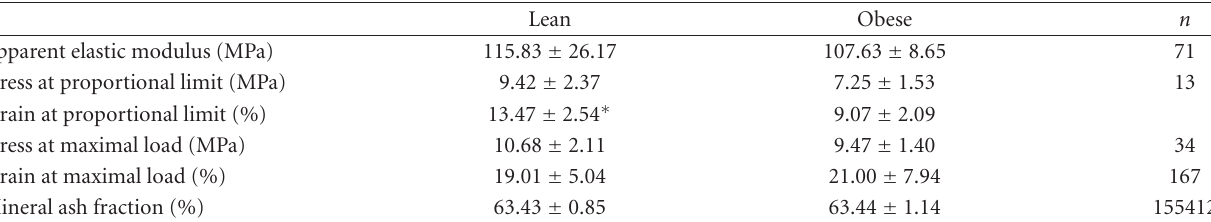
Table 6: L 6 material